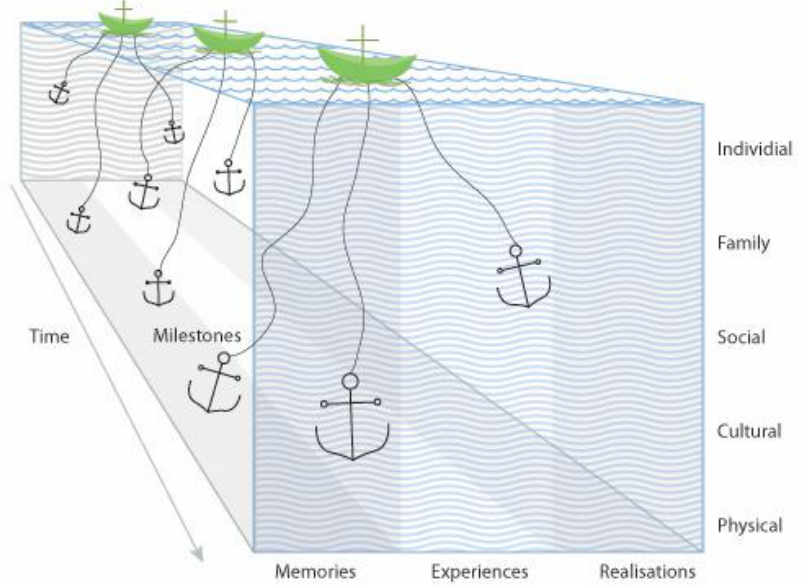
Figure 4. Place attachment can be visualised as anchors , with boats representing the individuals’ trajectory through life. Each memory, experience and realisation creates an anchor to a place within the context of individual, family, social, cultural and physical interactions with the place. Anchors can be consciously raised allowing people to move on or people experience loss, such as the loss of social connections which may sever the connection to a place, leaving people feeling adrift. This visualisation aims to demonstrate the fluid nature of place attachment, rather than as a fixed entity. (Source: the authors).